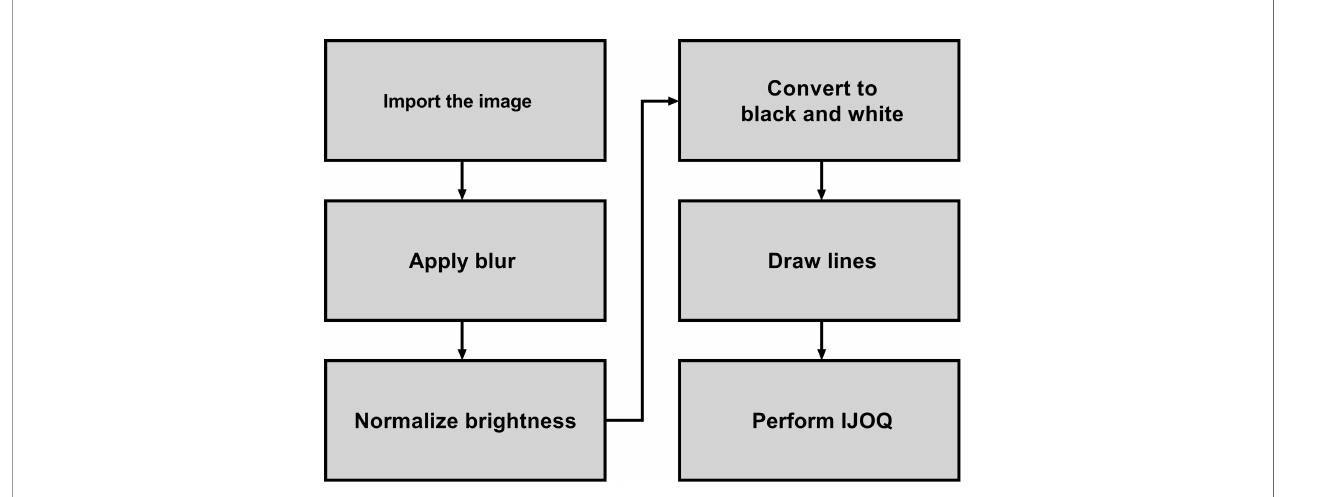
FIGURE 1 | Flowchart which depicts the steps used to analyze the image for AJ